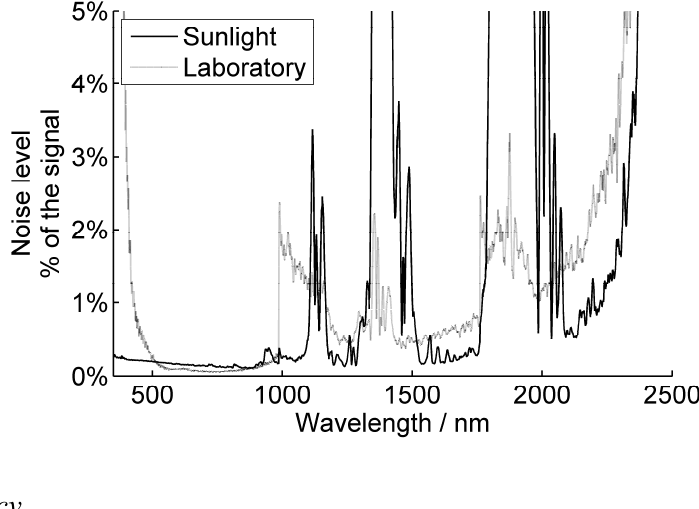
Figure 6. Typical noise levels in FIGIFIGO measurement of a white Spectralon panel. With darker samples, the noise levels are respectively higher. Sunlight measurement was made on an August afternoon in southern Finland (Sun zenith 54°). In the laboratory, the illumination zenith angle was approximately 45°. The sunlight spectrum shows increased noise at the atmospheric absorption bands around 1,200 nm, 1,400 nm, and 1,900. In the laboratory, the lower light levels enhance the noise at the spectrometer VNIR, SWIR1, and SWIR2 sensor borders (986 nm and 1,760 nm) as the sensitivities